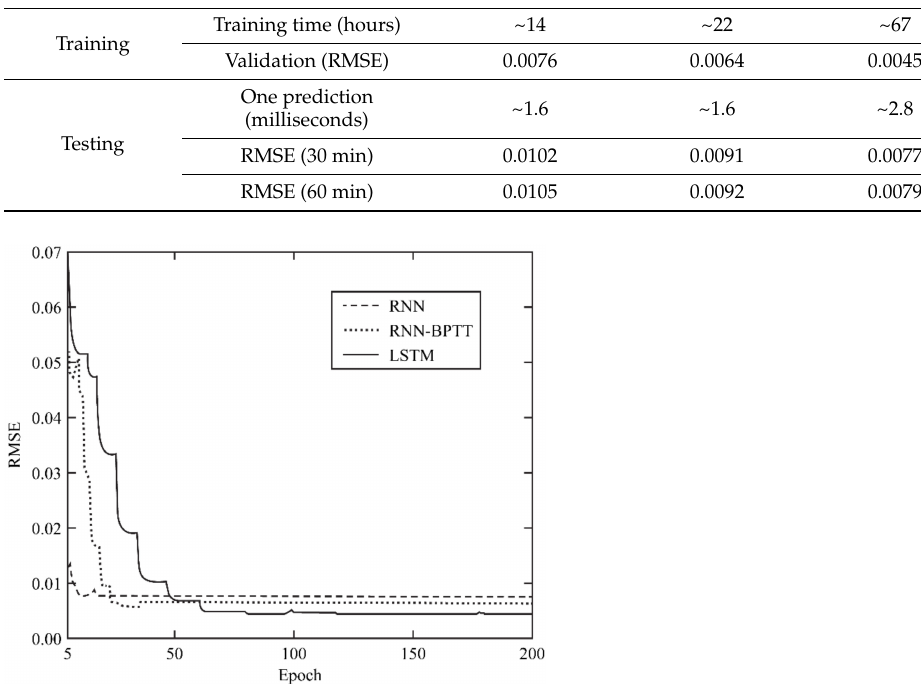
Figure 6. Convergence process of the three algorithms (after the fifth epoch) (Source: [7]).